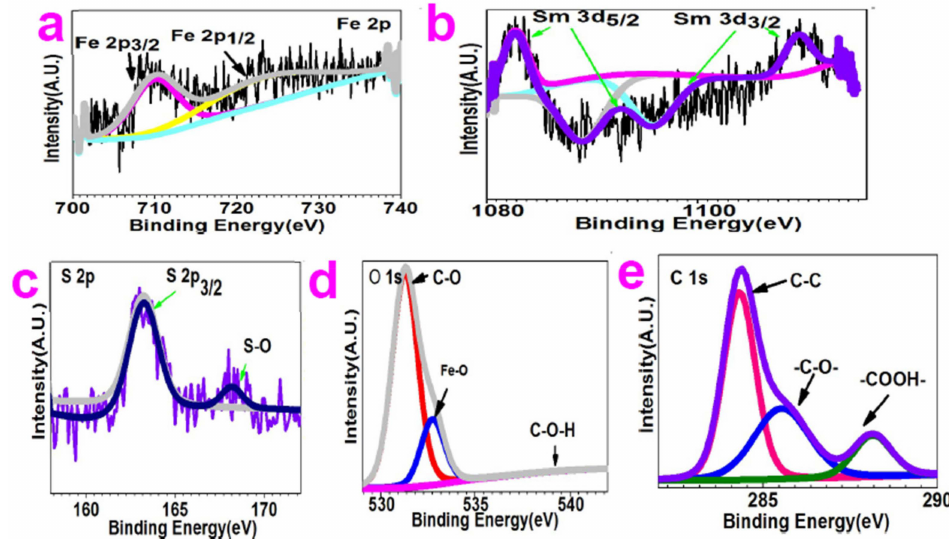
Figure 2. X -ray photoelectron high-resolution scanning spectra of Sm–Fe compound: ( a ) Fe 2p; ( b ) Sm 3d; ( c ) S 2p; ( d ) O 1s; ( e ) C